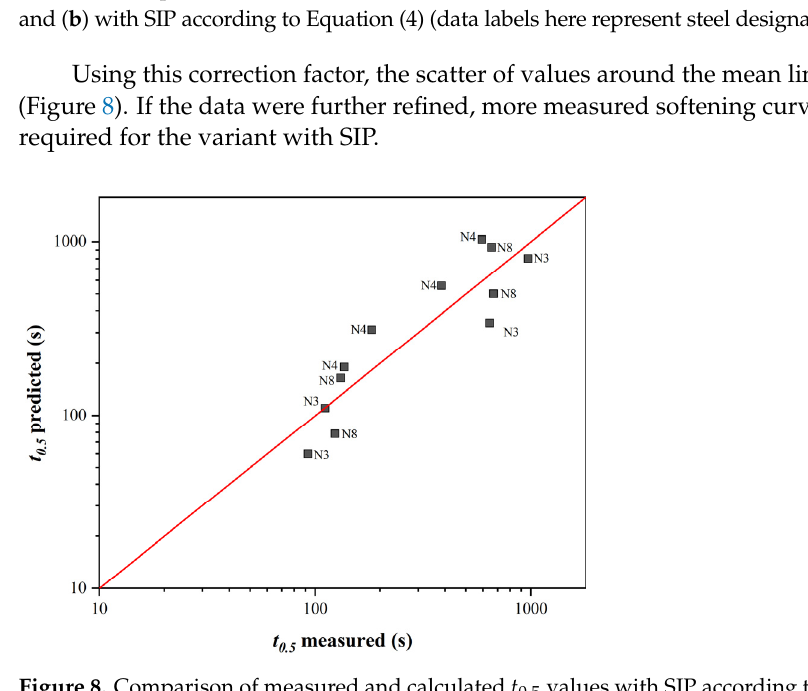
Figure 8. Comparison of measured and calculated t 0.5 values with SIP according to Equation (5) (data labels here represent steel designations).